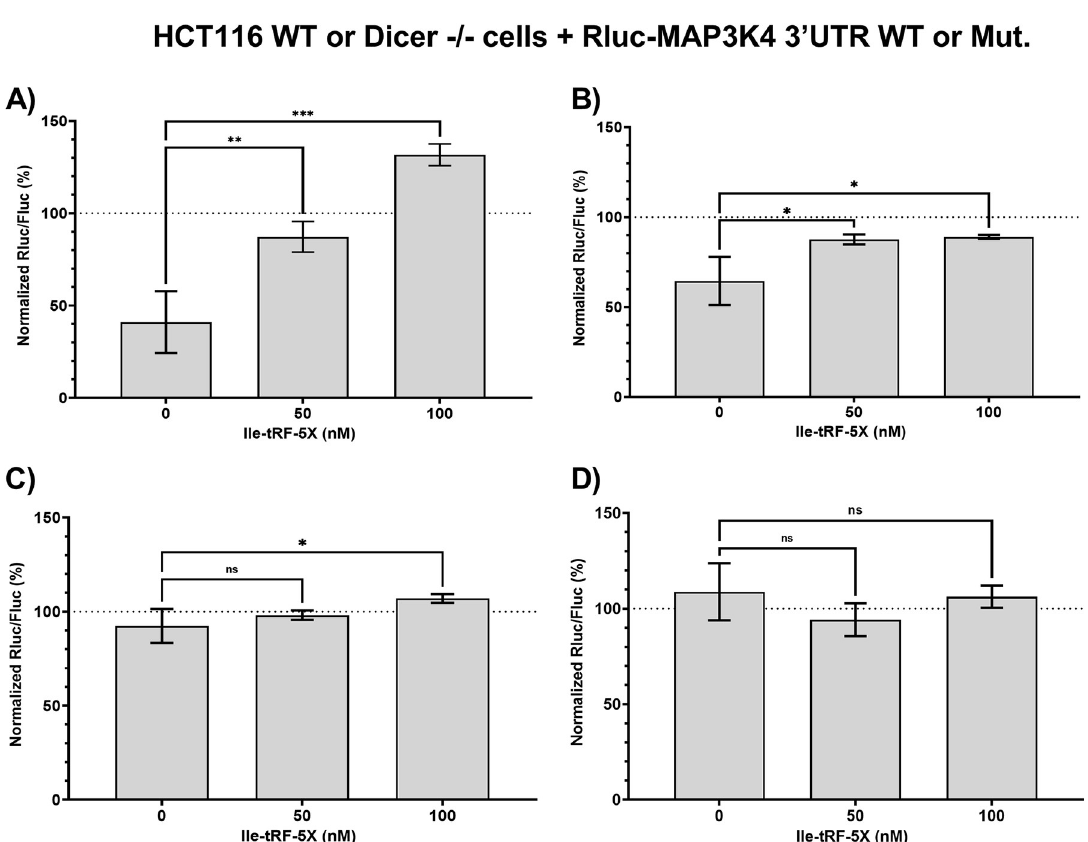
Fig 10. Bacterial Ile-tRF-5X counteracts the miRNA-induced gene downregulatory properties of MAP3K4 3’UTR. ( A-D ) Human HCT116 cells either wild-type (WT; A-B ) or Dicer -/- ( C-D ) were co-transfected with synthetic Ile-tRF-5X (0, 50, 100 nM) and a psiCHECK-II reporter construct (50 ng; see S7 Fig) in which the Rluc reporter gene was coupled with WT (A, C) or mutated (Mut., B, D) MAP3K4 3’UTR. The details of the applied mutations are indicated in the S1 Information. An unrelated 13-nt sequence (100 nM) was used as control (0 nM Ile-tRF-5X). Dual luciferase reporter gene activity assays were performed as described previously [54], with Fluc as a normalization reporter control. Statistical analysis . Data were calculated from three biological replicate measurements (n = 3; mean ± SD). One-way analysis of variance (ANOVA) and Holm-Sˇı´da´k’s multiple comparisons (post-hoc test) were used for statistical analysis. Statistically significant differences are indicated as follows: � p < 0.05; �� p < 0.01; ��� p < 0.001. ns, not